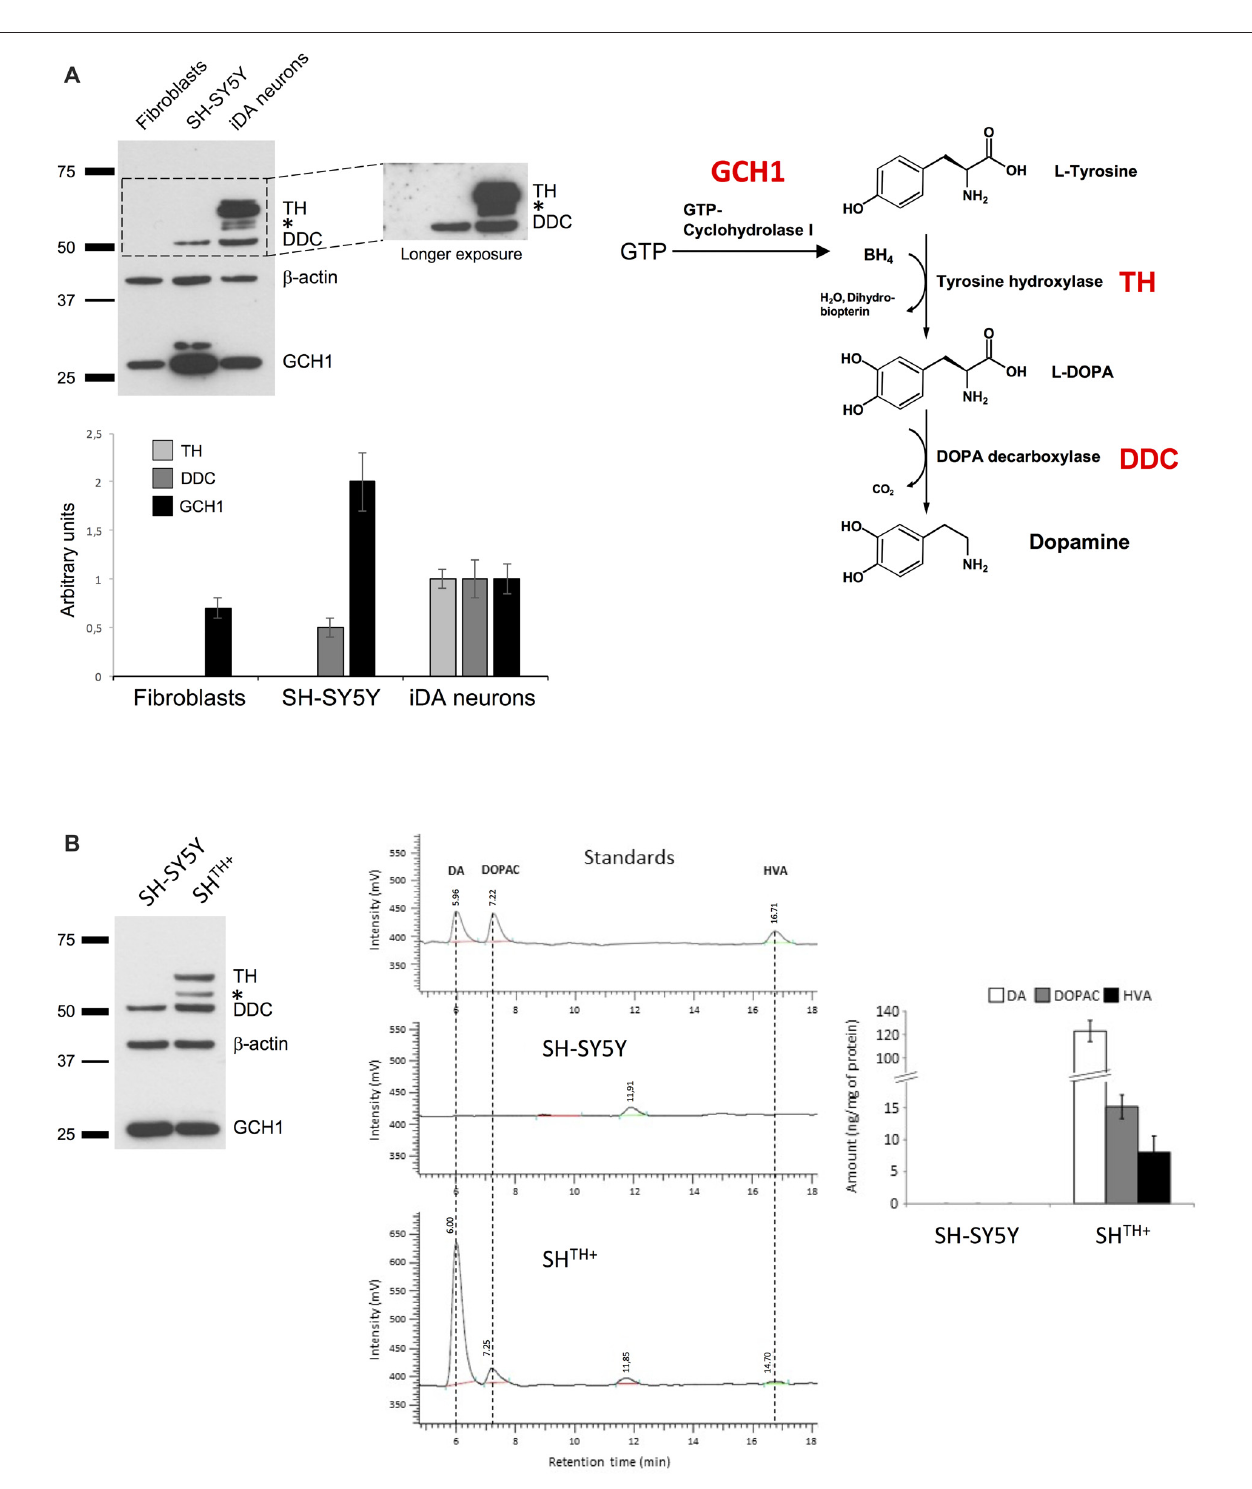
FIGURE 1 | Ectopic expression of TH is sufficient for dopamine synthesis in SH-SY5Y cells. (A) Western blot analysis of DDC, TH and GCH1 in human dermal fibroblasts, SH-SY5Y cells, and induced pluripotent stem cells (iPSCs)-derived neurons. β -actin served as a loading control. (B) Proteins from naive SH-SY5Y and SH-SY5Y cells expressing TH (SH TH + ) were extracted and analyzed using antibodies against TH, DDC and GCH1. Dopamine synthesis was detected only in SH TH + cells, but not in SH-SY5Y cells. BH4, tetrahydrobiopterin; TH, tyrosine hydroxylase; L- DOPA, L-3,4-dihydroxyphenylalanine; DDC, DOPA decarboxylase; GCH1, GTP cyclohydrolase 1; ∗ non-specific